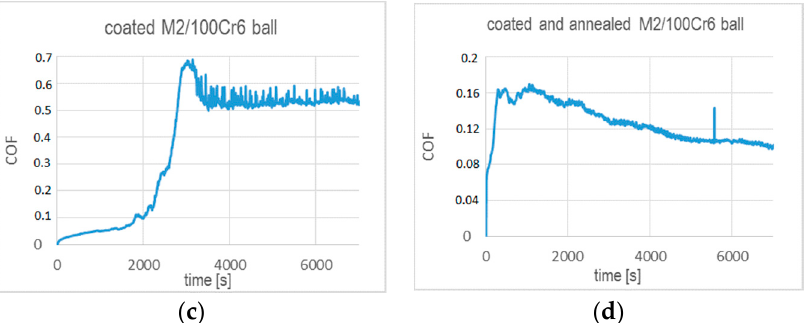
Figure 7. Coefficient of friction versus test time determined in dry sliding in ball-on-disc tests for the (TiB x /TiSi y C z )x3 multilayer on M2 steel in as-deposited and annealed states against ( a , b ) alumina ball, ( c , d ) 100Cr6 ball, as counterparts.